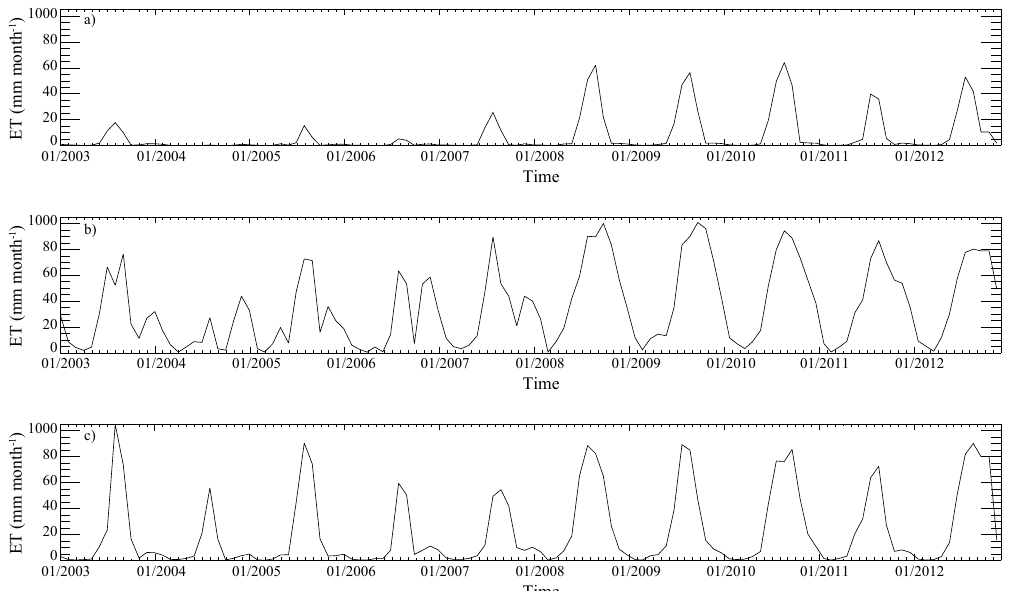
Figure 10. Evapotranspiration rate evolution for three different pixels (see locations in Figure 1): ( a ) is located in the Kadzell region at 13.16 ◦ E–13.74 ◦ N, ( b ) is located inside the Lake Chad bed at 14.21 ◦ E–13.14 ◦ N, and ( c ) is located at 12 ◦ N, in a clay rich region at 13.36 ◦ E–12.12 ◦ N. The ET data of the first pixel show an ET rate of ~200 mm month − 1 during the rainy season up to 2008, except for the 2004-WAM episode where there is no signal. Since 2008, the ET rate has increased to ~500 mm month − 1 . The ET rate evolution on the second pixel (Figure 10b) and the third one (Figure 10c) is particularly interesting as the signal can be divided into two periods: the first period from 2003 to early 2008 and the second one from 2008 to